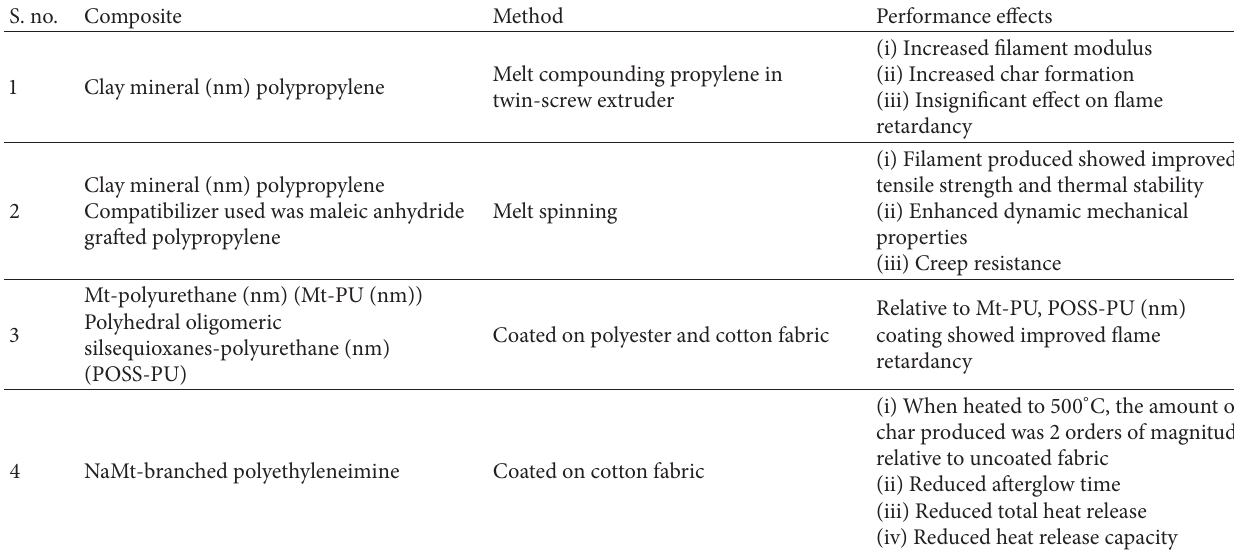
Table 4: Clay mineral effects on filament fibers and